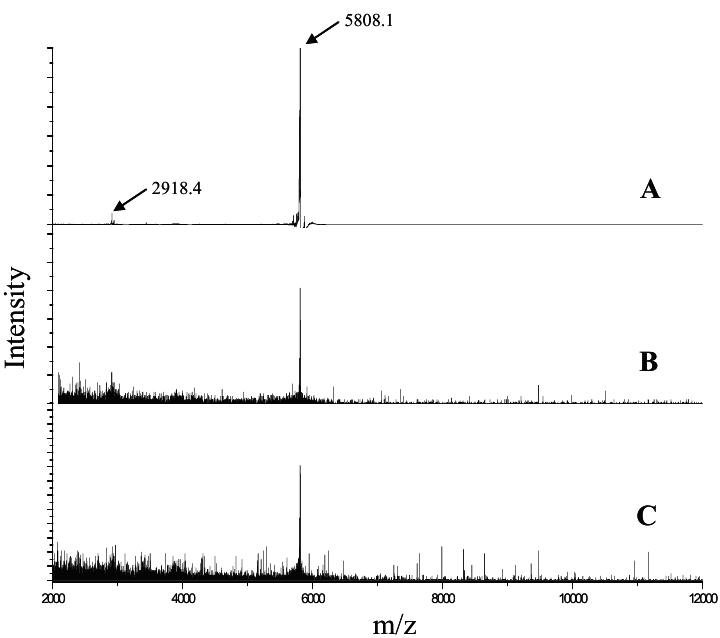
Figure 6. Matrix-assisted laser desorption/ionization time-of-flight (MALDI-TOF) mass spectrum of ( A ) native insulin; ( B ) insulin extracted after homogenization at 10,000 rpm; and ( C ) insulin with zinc extracted after homogenization at 10,000 rpm.